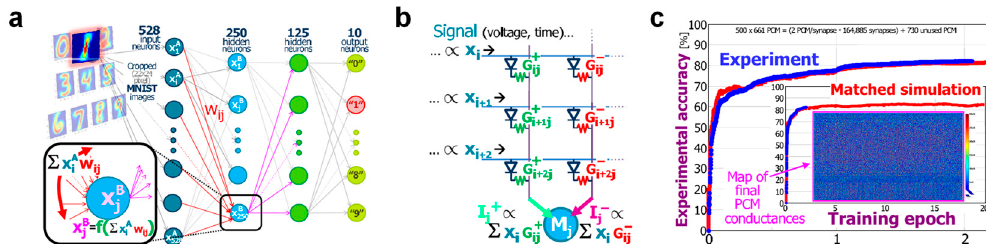
Figure 13. ( a ) Schematic representation of a three-layer DNN operated on the MNIST database for an image classification task. ( b ) Weight implementation in DNN by differential pairs of 1T1R PCM cells with conductances G ij + and G ij − , which provide a positive current and a negative current, respectively. ( c ) Experimental classification accuracy achieved by three-layer DNN during the inference phase.